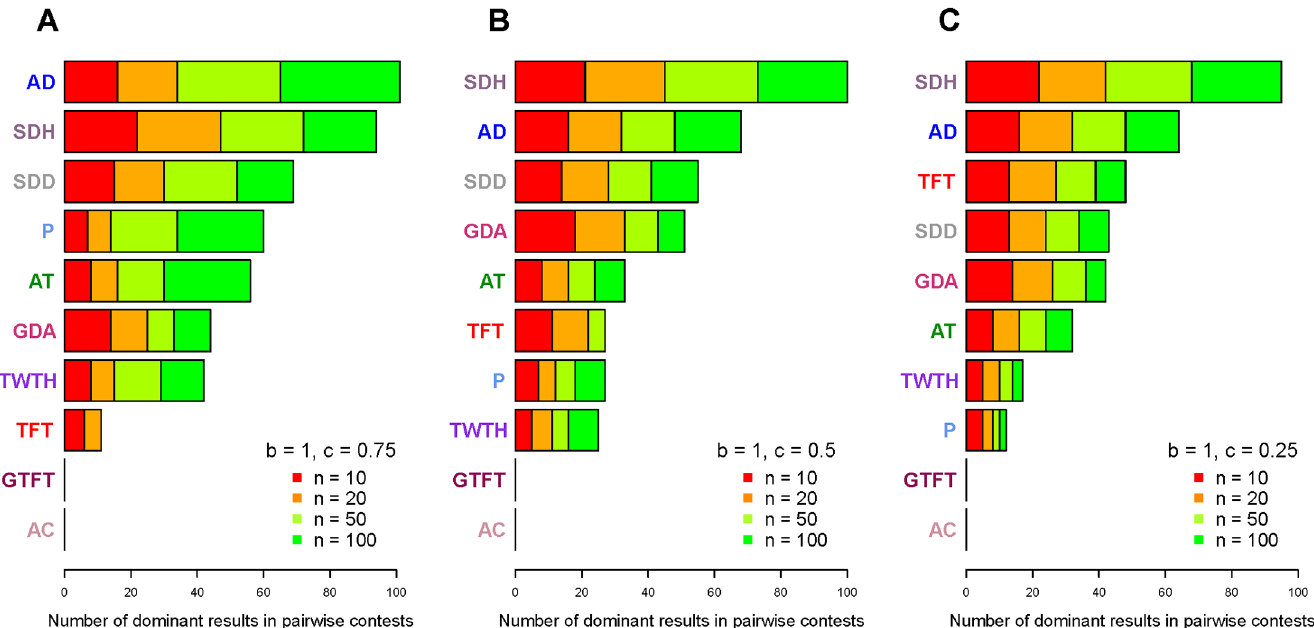
Fig 2. The number of dominant results for nine strategies tested in pairwise contests. AC stands for always-cooperate. AD stands for always-defect. AT stands for always-trembling. TFT stands for tit-for-tat. GTFT stands for generous tit-for-tat. TWTH stands for TFT-with-trembling-hand. SDH stands for shame-driven-hiding. SDD stands for shame-driven-denying. GDA stands for guilt-driven-amending. P stands for Pavlov. (A) When b = 1 and c = 0.75, the ranking of nine strategies. (B) When b = 1 and c = 0.5, the ranking of the strategies. (C) When b = 1 and c = 0.25, the ranking of nine strategies.